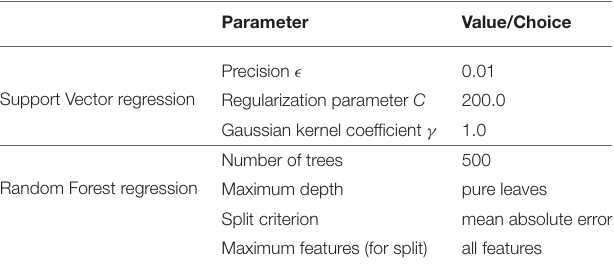
TABLE 1 | ML parameters used for SVR and RFR (scikit-learn library, cf. Pedregosa et al., 2011); Other parameters are default